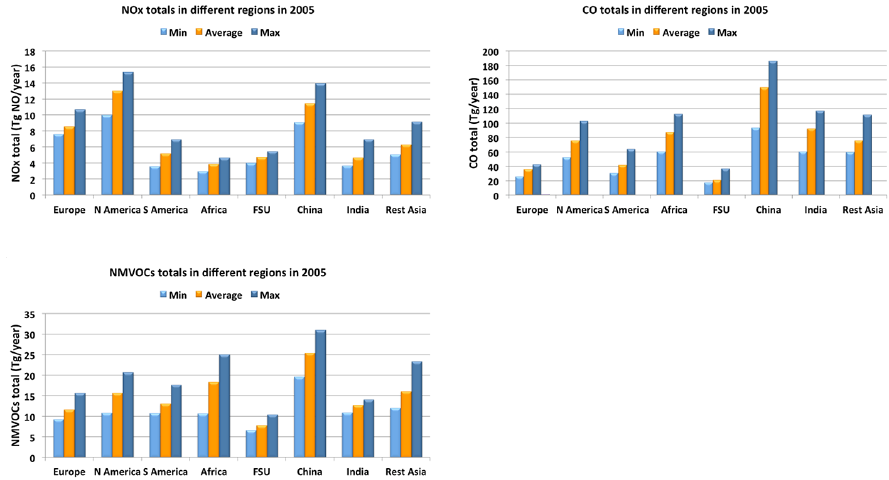
Figure 15. Minimum, average and maximum emissions taken from various inventories of NO x , CO and NMVOCs for different regions of the world in 2005 (FSU – former Soviet Union). The emissions of NO x are reported in TgNOyr − 1 .